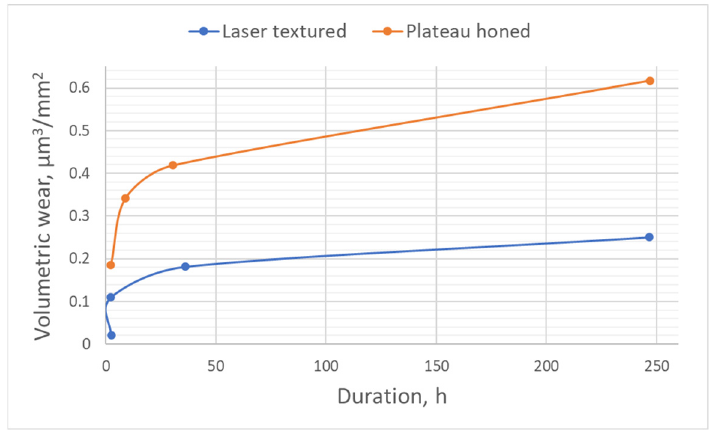
Figure 18. Relative volumetric wear levels of cylinder liners, after [118].